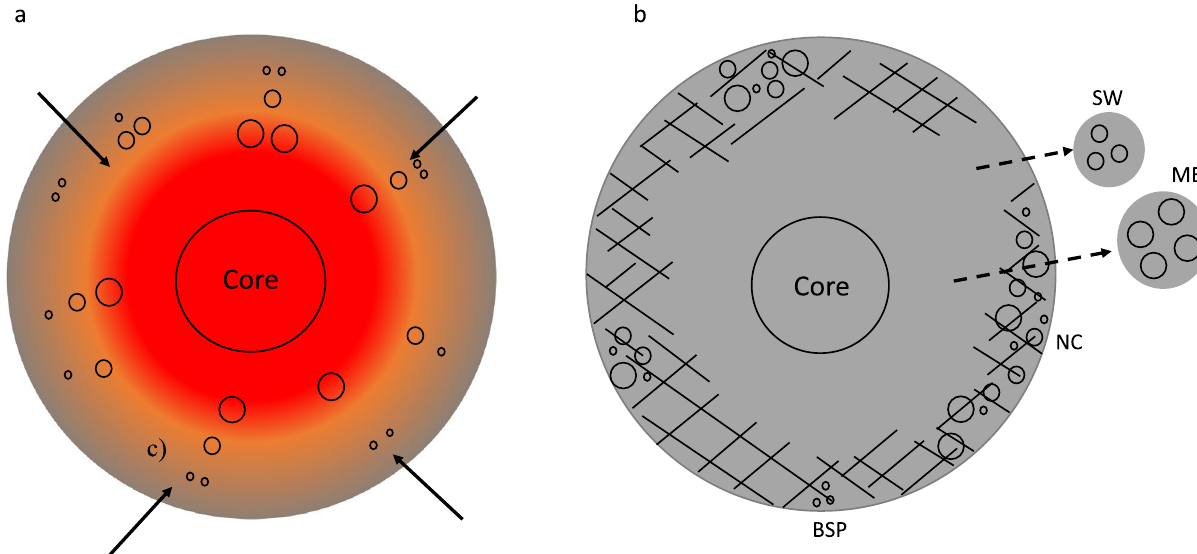
Figure 4. ( a ) Schematic illustration of the aubrite parent body (AuPB) at a time within 4.3 Myr after CAI formation, with warmer colors indicating higher temperatures. Silicon contents and Fe isotope compositions of metal grains in aubrites likely record a thermal gradient with depth from surface (larger circles represent metal grains recording higher equilibration temperatures). Impacts (shown as arrows) at this time, while the AuPB